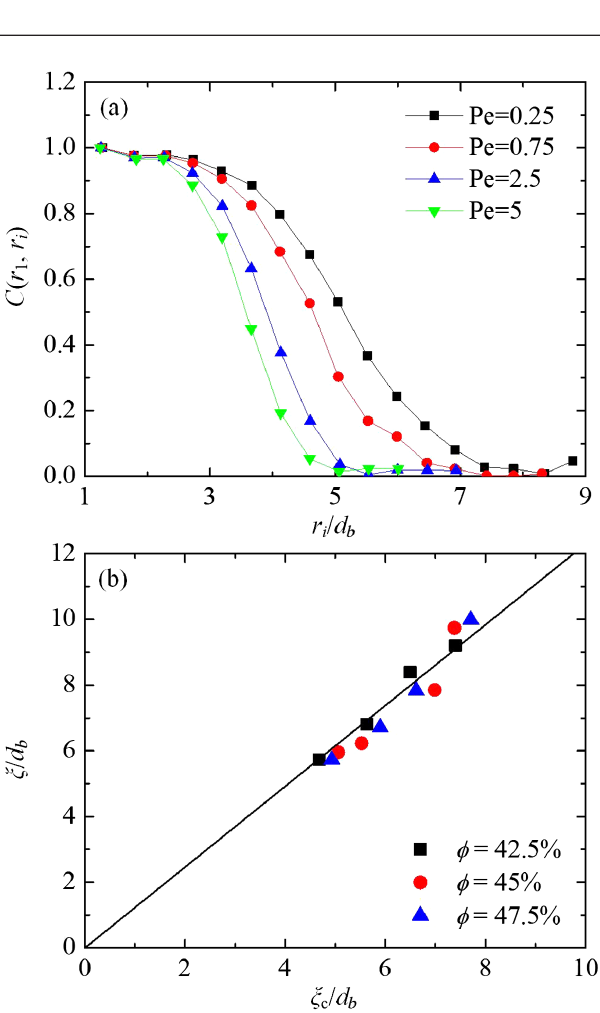
as a function of r for the ϕ ¼ 45% system i Þ i becomes i Þ ≲ 2% . Therefore, we set 2% as the i Þ . (b) Scatter plot of ξ and ξ for all i Þ c c